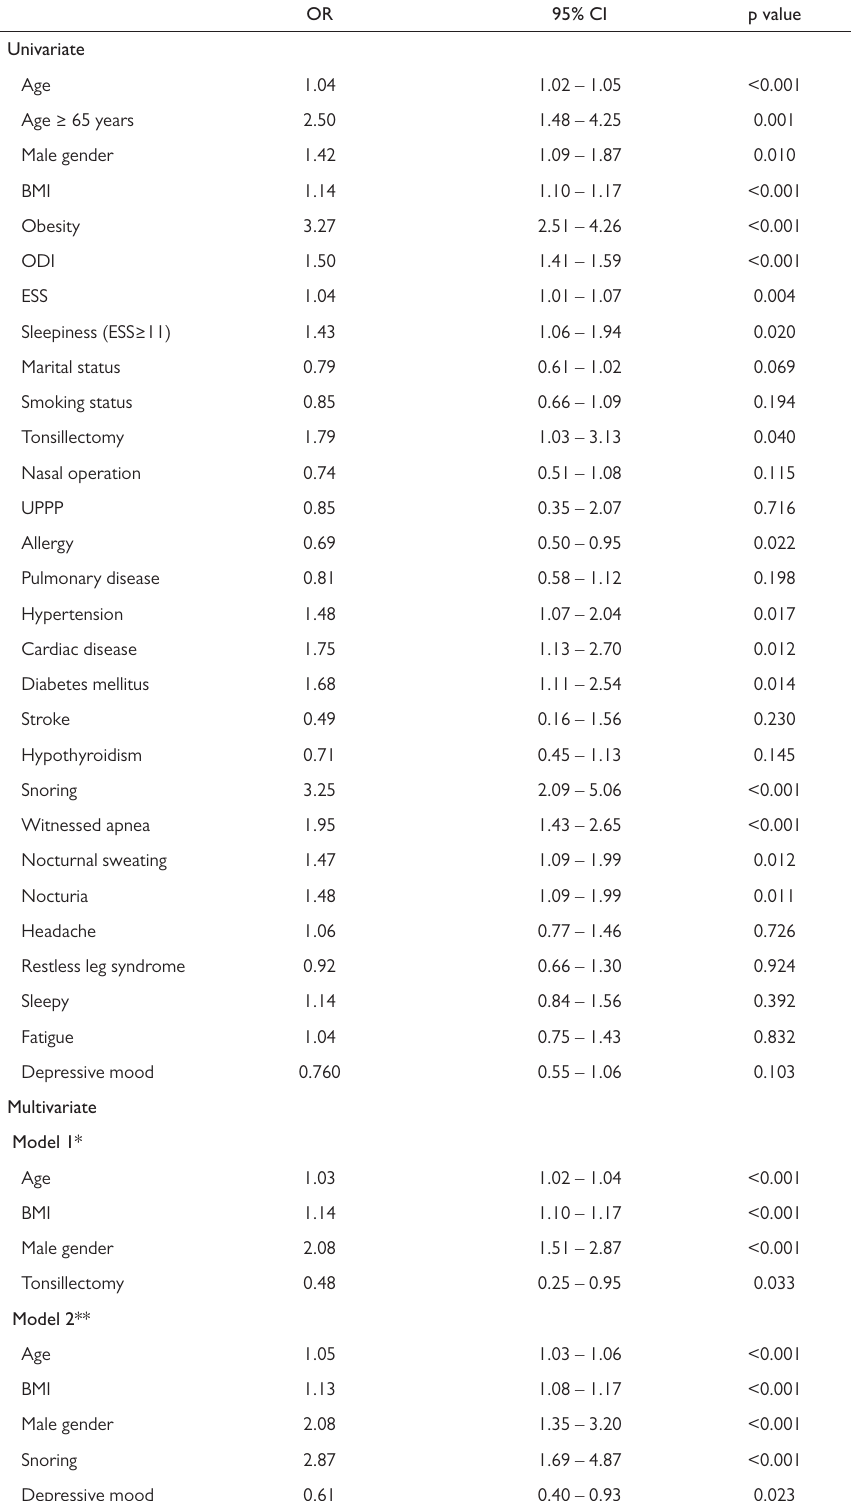
Table 3. Associates of obstructive sleep apnea (AHI ≥ 15 events/h) in the whole study population (n=1042) OR 95%